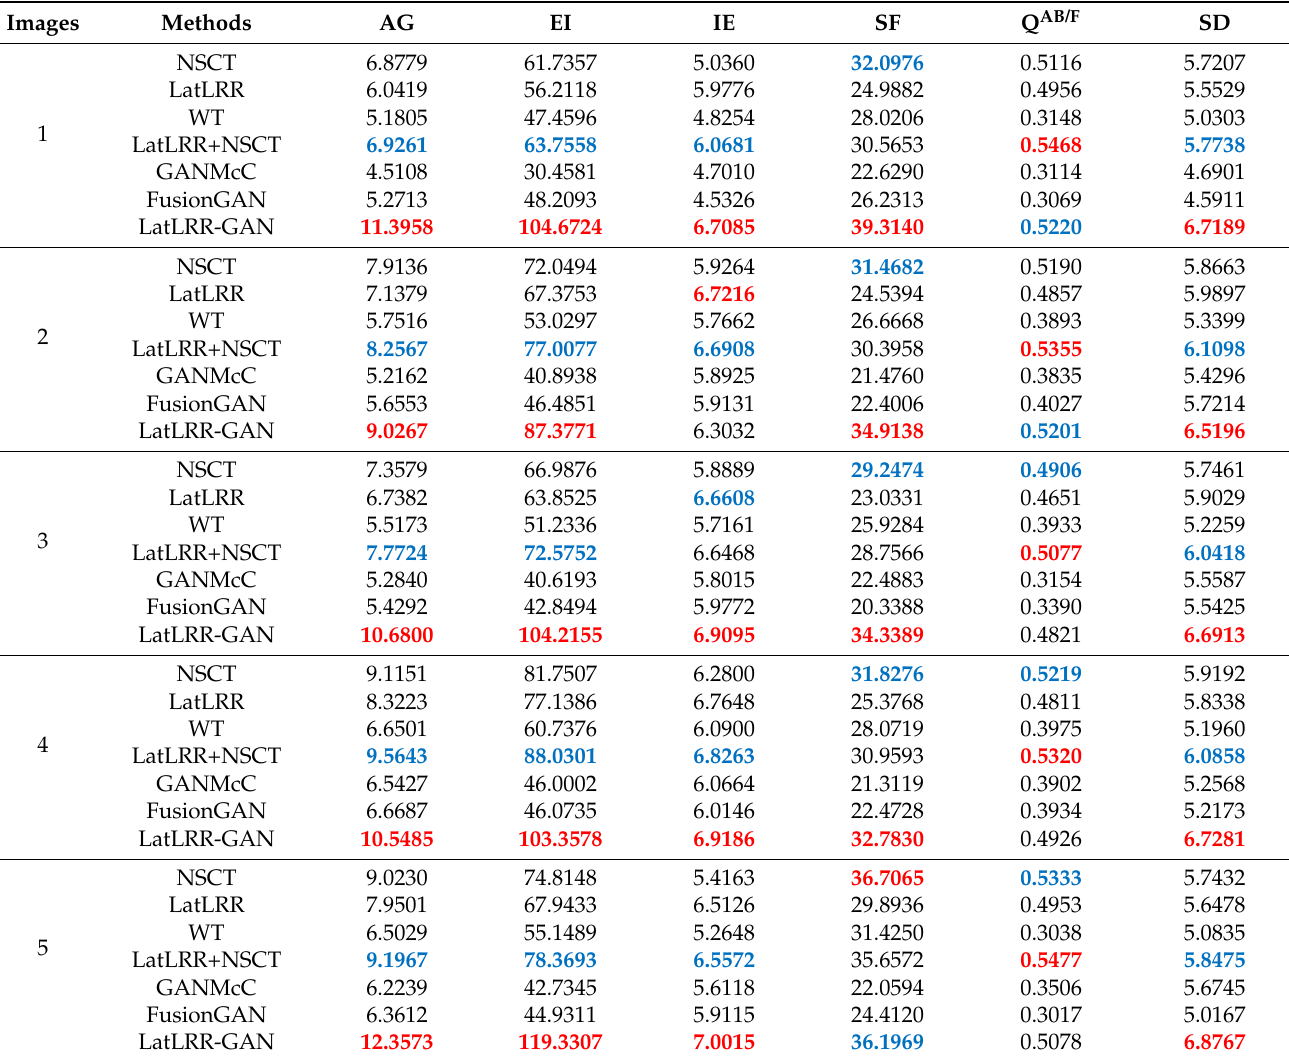
Table 2. The results of fused images’ evaluation metric values of CT mediastinal window images and PET images. Method 1: NSCT; Method 2: LatLRR; Method 3: WT; Method 4: LatLRR+NSCT; Method 5: GANMcC; Method 6: FusionGAN; Method 7: LatLRR-GAN. The best evaluation metric values are represented in red; the second-best evaluation metric values are represented in